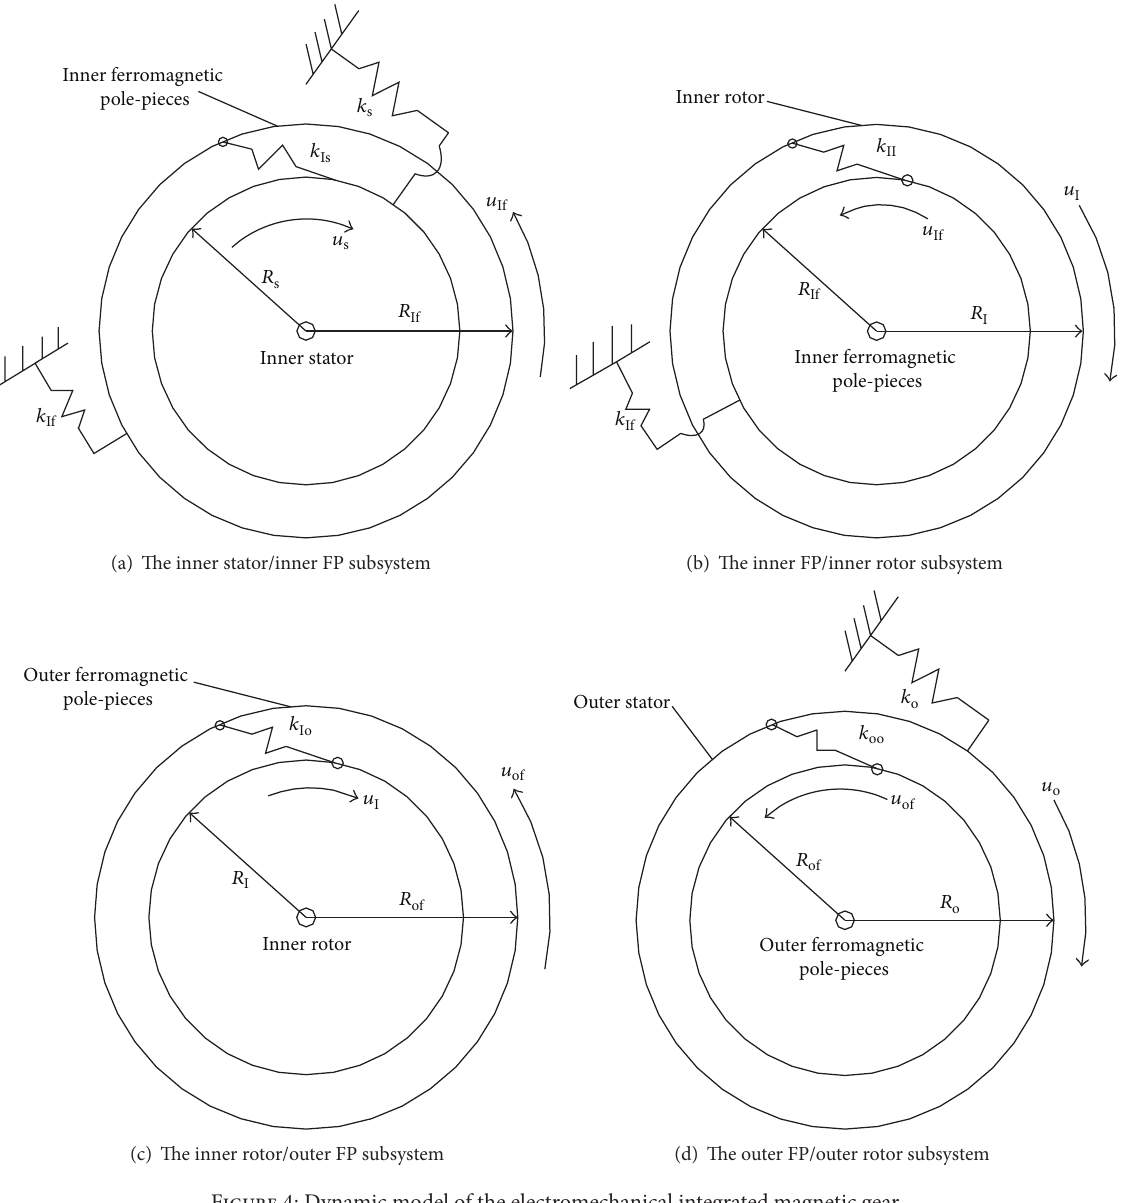
Figure 4: Dynamic model of the electromechanical integrated magnetic